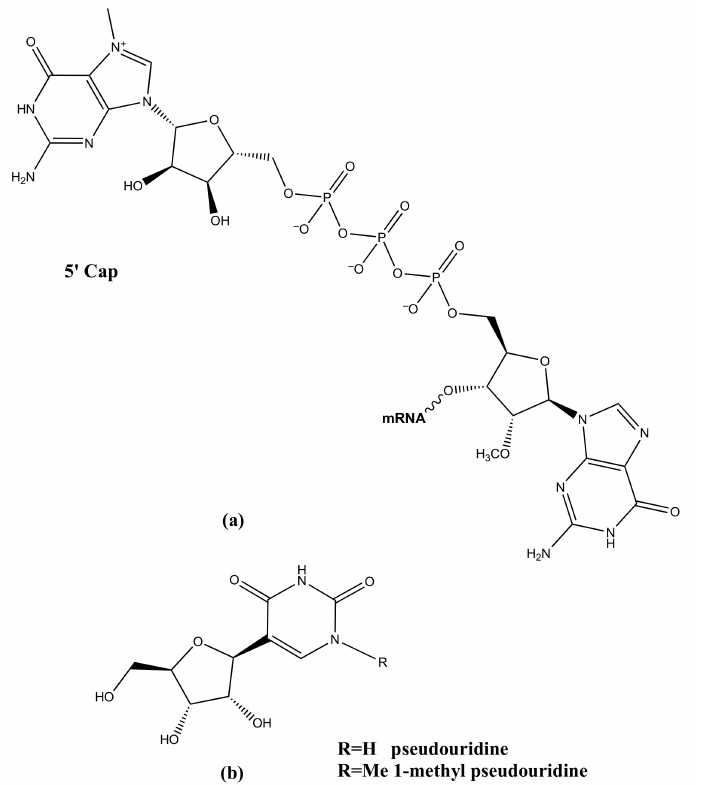
Figure 3. Schematic representation of some typical modifications of synthetic mRNAs contained in the COVID-19 vaccines: ( a ) 5 (cid:48) capping via cap1 structure (m7GpppNm); ( b ) uridines are replaced with pseudouridine or 1-methyl pseudouridine